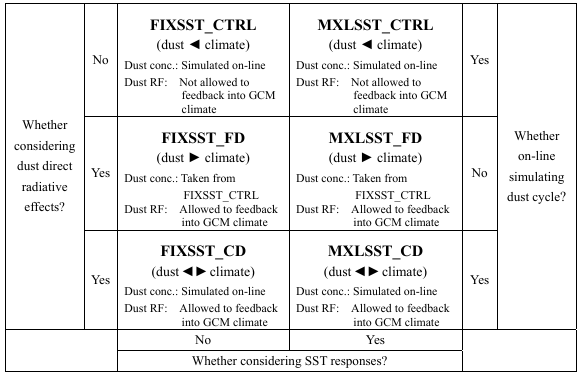
Fig. 1. Summary of numerical experiments. 753